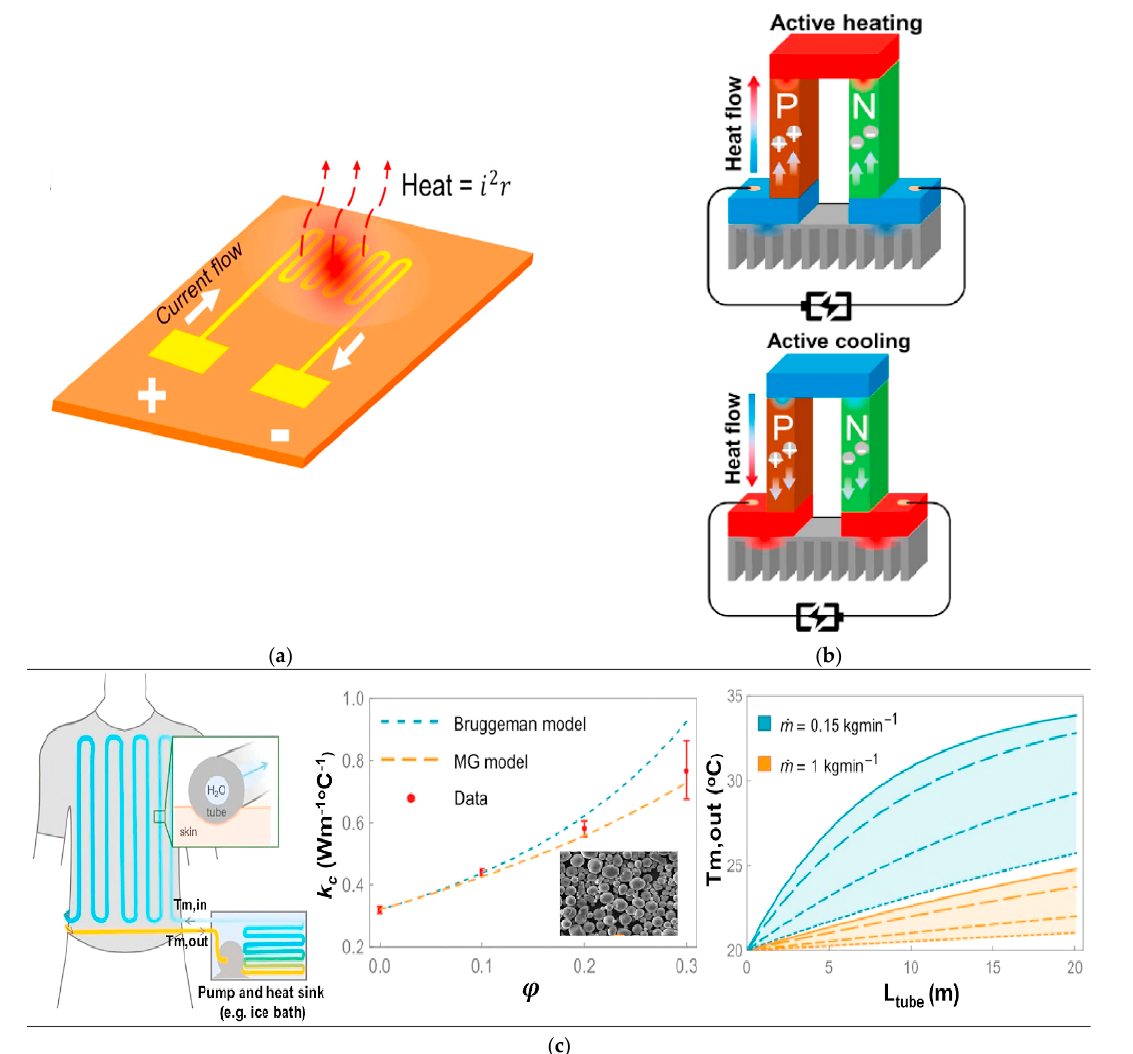
Figure 6. Thermal-based haptic interfaces. Joule-heating interface for haptic feedback: schematic representation of Joule heaters [24] ( a ); haptic feedback interfaces utilizing thermal electric actuators. A diagram of a thermoelectric mechanism [2] ( b ); microfluidic and other thermal-based haptic interfaces. The systems for micro-fluidic heat transfer are depicted schematically (left). Thermoregulatory clothing that circulates liquid cooling through flexible, thermally conductive silicone aluminum tubes to cool the body (center and right) ( c